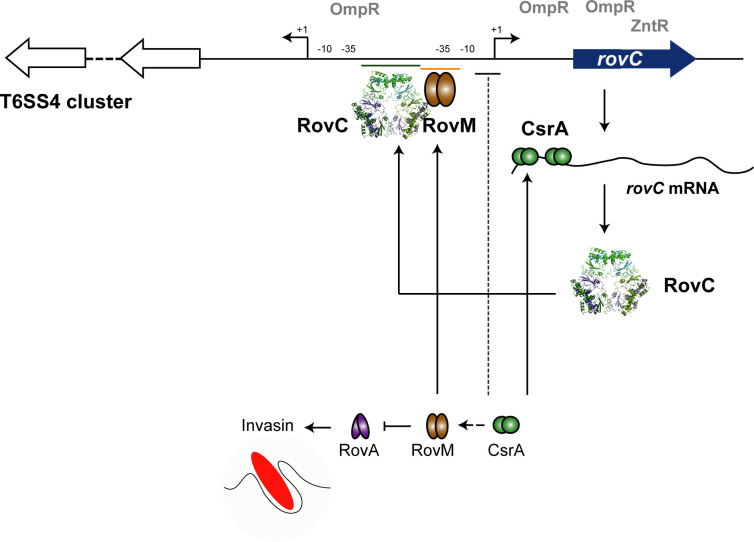
Model of rovC regulation and RovC-dependent T6SS4 activation.Schematic representation of the T6SS4 and rovC upstream region. The RovC binding region is marked in green, the RovM binding site in yellow. The transcriptional start sites of the T6SS4 operon and the rovC gene are indicated with +1 and a broken arrow. The -10 and -35 regions of the T6SS4 and the rovC promoter are indicated. The hexameric regulatory factor RovC is illustrated with its crystal structure, the dimeric regulators CsrA, RovM and RovA are indicated by symbols. Activation of gene expression is illustrated by arrows; indirect inhibition of expression is given by a dashed line.